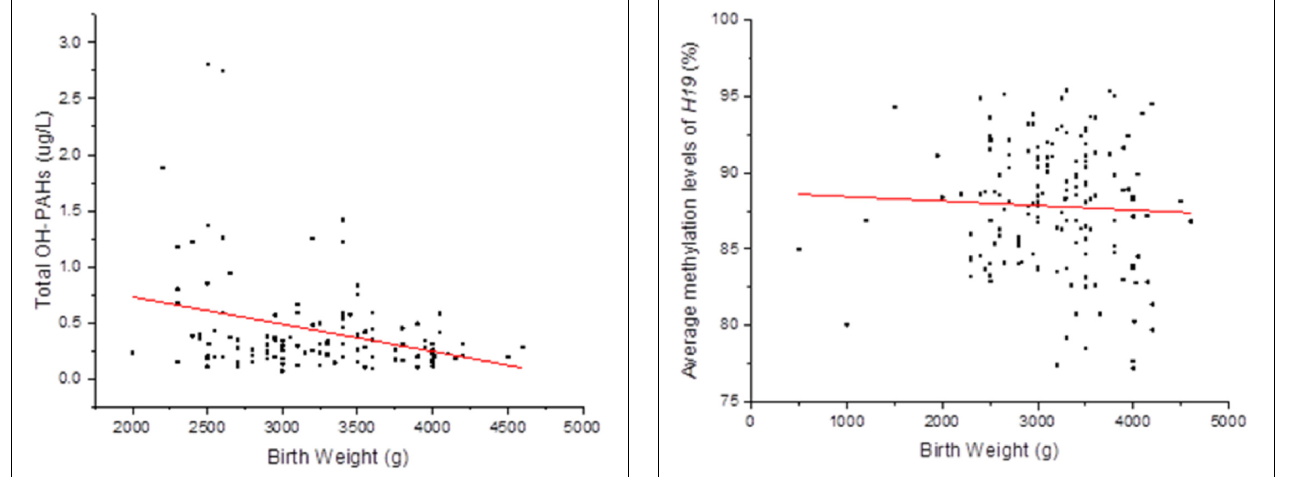
FIGURE 1 | Correlation between total OH-PAHs levels and new born BW. Total OH-PAHs levels were negative correlated to new born BW in this study. Each point on the graph represents individual measurement and red line represents Liner fit trend.